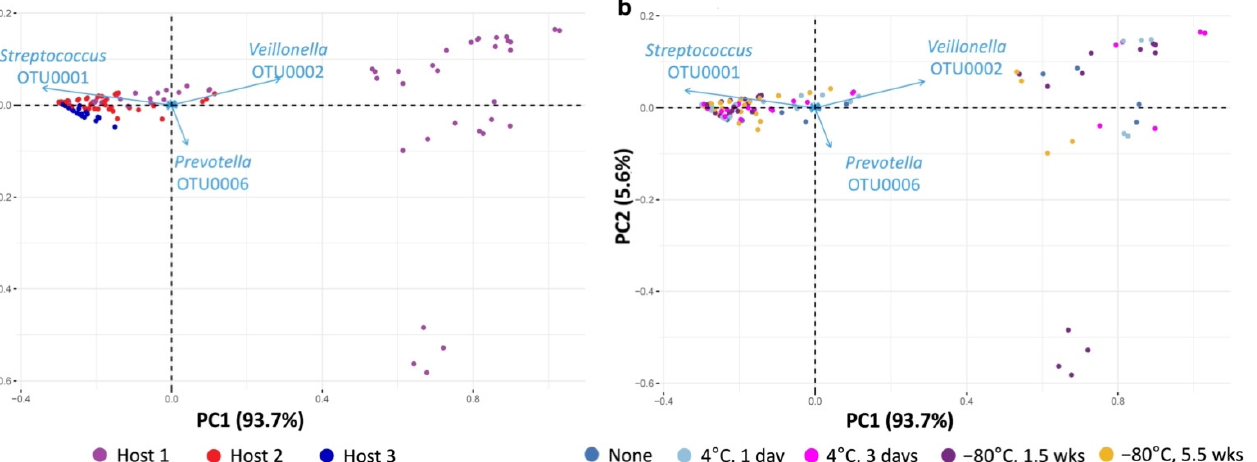
Figure 5. PCA biplots of relative abundances, by host ( a ) or preservation condition ( b ). Each dot represents a single sample (see legend). Arrows depict major OTUs in the dataset. Note the presence of a cluster of diminutively short arrows near the origin, containing OTUs that do not contribute substantially to the variation in the dataset. Dimension 1: Streptococcus OTU001 (–), Veillonella OTU002 (+); Dimension 2: Prevotella OTU006 (–), Veillonella OTU002 (+), Streptococcus OTU001 (+).